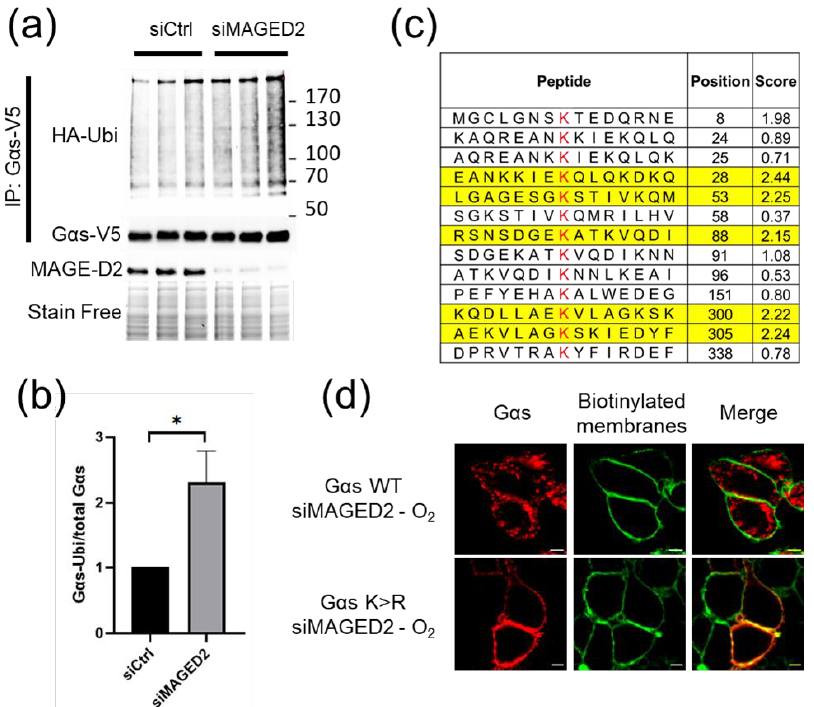
Figure 5. MAGED2 inhibits G α s ubiquitination under hypoxic condition. ( a ) MAGED2 regulates G α s ubiquitination. HEK293 cells, transiently transfected with G α s-V5 and ubiquitin-HA, were immunoprecipitated with anti-V5 under denaturing conditions. Ubiquitinated G α s was detected with anti-HA antibody. ( b ) Densitometric analysis of ( a ), shown as ratio of ubiquitinated G α s and total G α s immunoblot. Statistical significance was determined by unpaired two-sided Student’s t -tests. Data are shown as a representative result from three independent experiments. Bar graphs show mean ± SEM. * p ≤ 0.05. ( c ) The ubiquitination sites of G α s were predicted with a Bayesian Discriminant Method [24] and the predicted sites with a score ≥ 2 were chosen for mutation (yellow). ( d ) Immunofluorescence microscopy showing distribution of wild type (WT) or a Gas-HA variant harboring 5 lysine-to-arginine substitutions (5 × K > R) in HeLa cells under physical hypoxia. Cells were stained with mouse anti-HA antibody for G α s (Alexa 555, Red) and plasma membrane biotinylated proteins (Alexa 488, Green). The yellow color (merged image) indicates co-localization of the proteins. Scale bars, 5 μm.